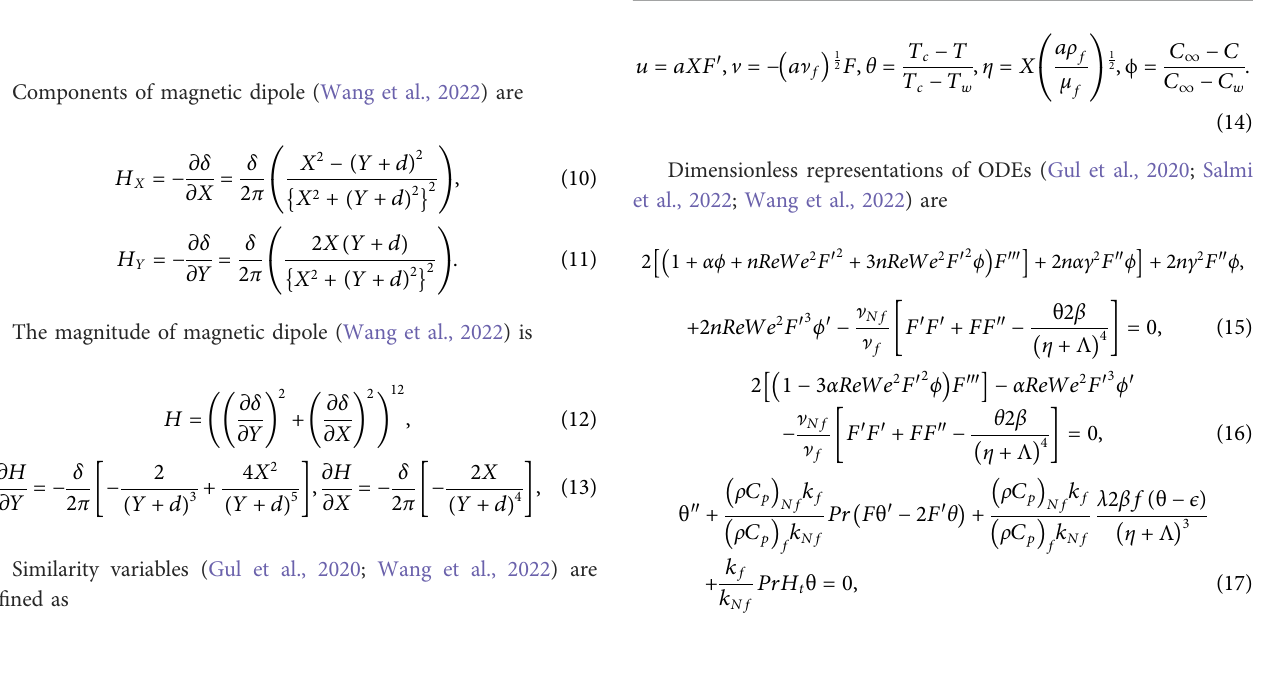
FIGURE 2 Effect of We on velocity curves when α (cid:2) 0 . 4 , n (cid:2) 0 . 2 , Re (cid:2) 2 . 0 , γ (cid:2) 0 . 2 , β (cid:2) 1 . 3 , Λ (cid:2) 0 . 32 , Pr (cid:2) 5 , ϵ (cid:2) 0 . 1 , H t (cid:2) − 1 . 6 , Sc (cid:2) 0 . 4 , λ (cid:2) 0 . 4 , K c (cid:2) − 1 . 5 , χ (cid:2) 0 . 3 , and τ (cid:2) 0 . 3.